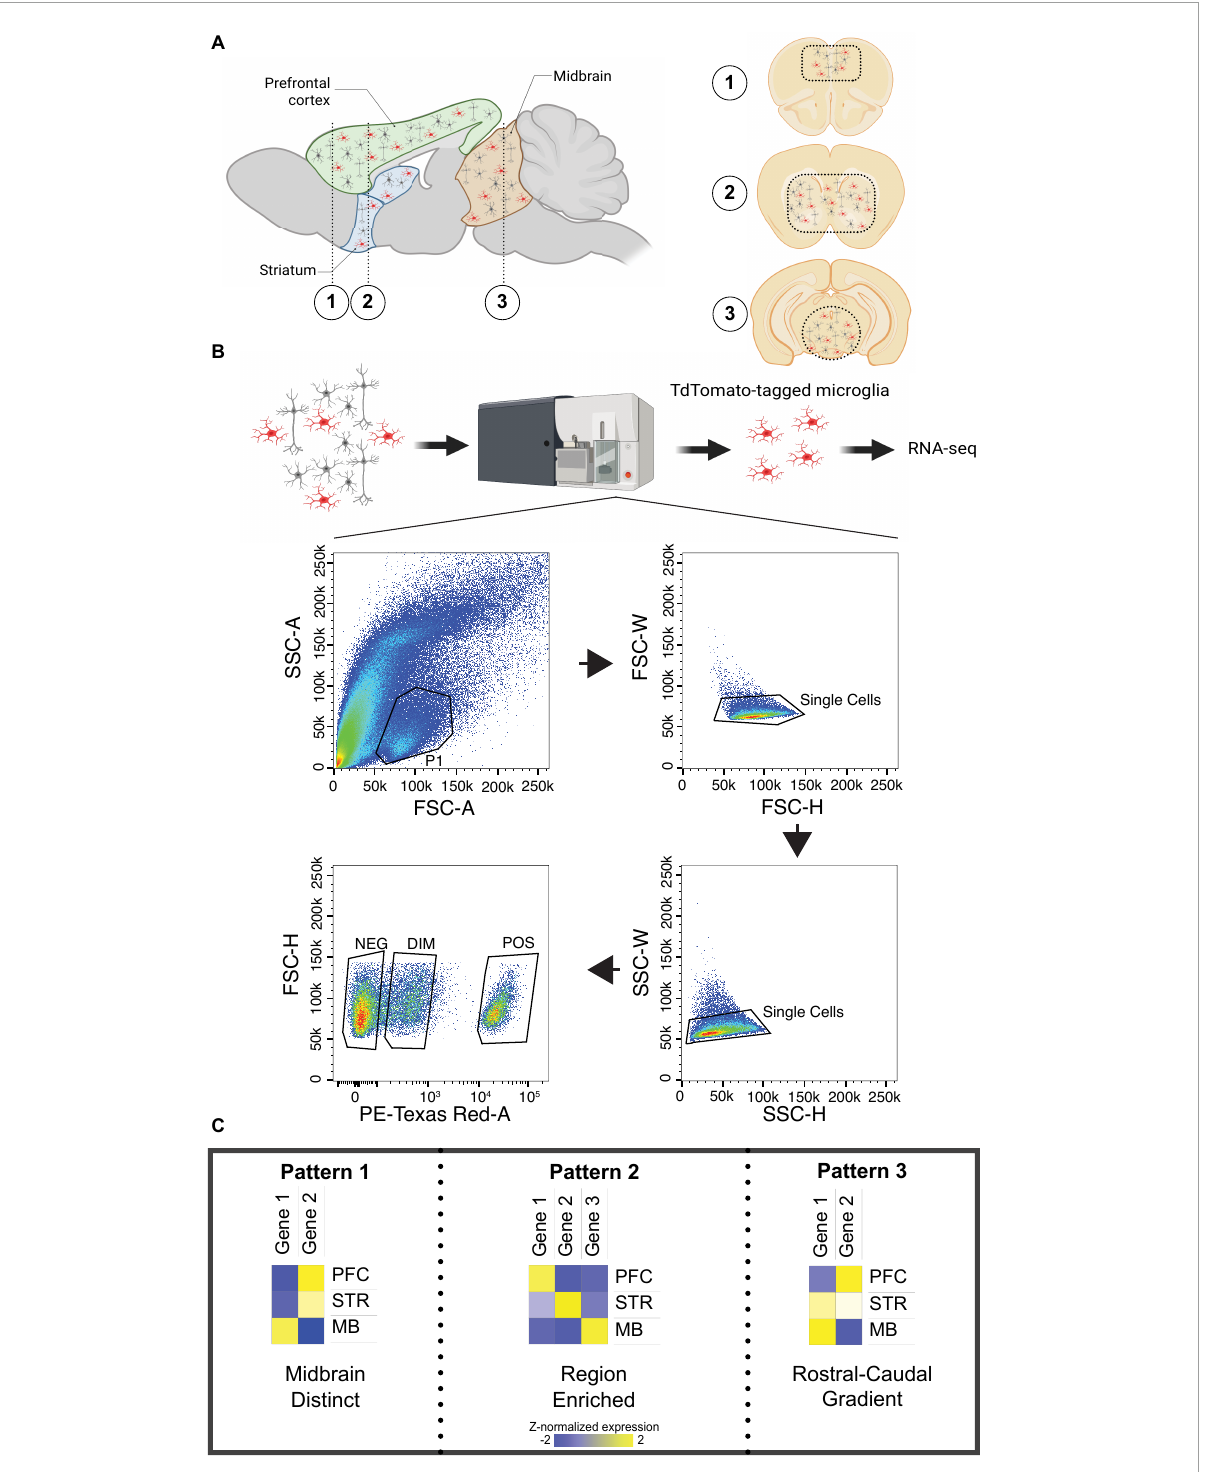
FIGURE1 Brain regions investigated and patterns of differential expression across regions. (A) Left. Sagittal section of the mouse brain with prefrontal cortex (PFC), striatum (STR), and midbrain (MB) labeled. (A) Right. Coronal sections of the mouse brain corresponding to the numbered regions in the left sagittal section. Dashed lines indicate the approximate location of tissue isolation for each region. (B) Experimental design for microglia isolation with fluorescent-activated cell sorting, including the gating strategy. Only cells identified as Td-Tomato positive were sequenced. (C) Patterns of transcript expression across investigated brain regions. Pattern 1 was associated with distinct expression in the midbrain. Pattern 2 was associated with enrichment in either PFC or striatum. Pattern 3 was associated with a rostral-to-caudal gradient of expression. Created with